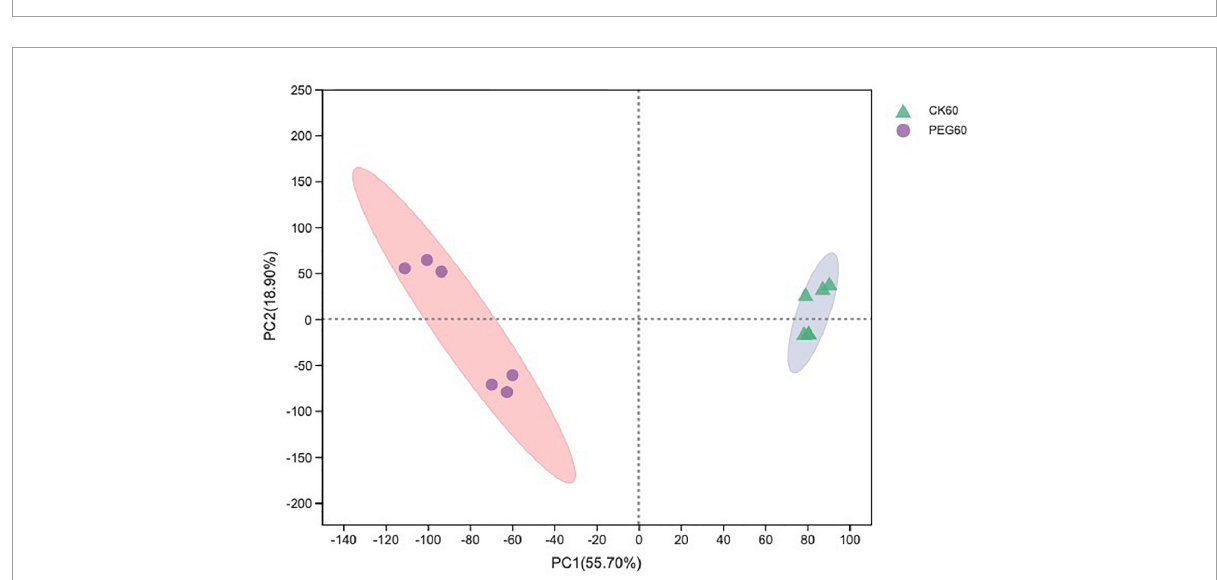
FIGURE4 The principal component analysis (PCA) score plot of the metabolites in sainfoin silage (CK 60, control group after 60 days of ensiling; PEG 60, PEG-treated group after 60 days of ensiling).